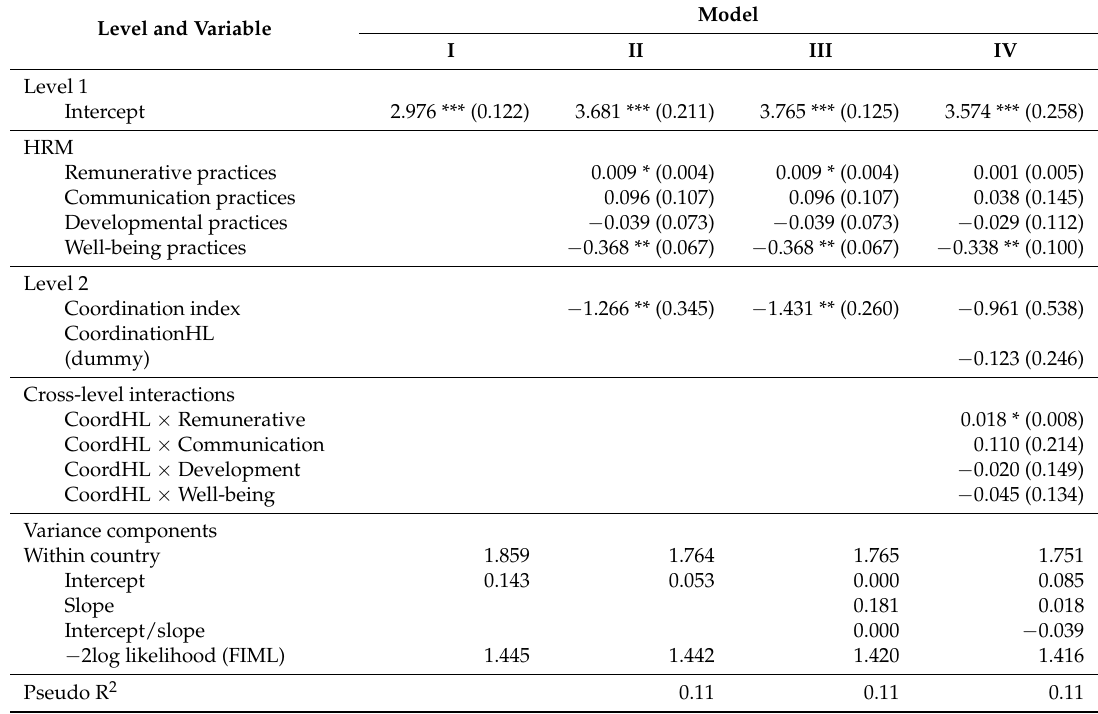
Table 3. Cross-Level Interaction of HR Practices and Coordination Index on Collective